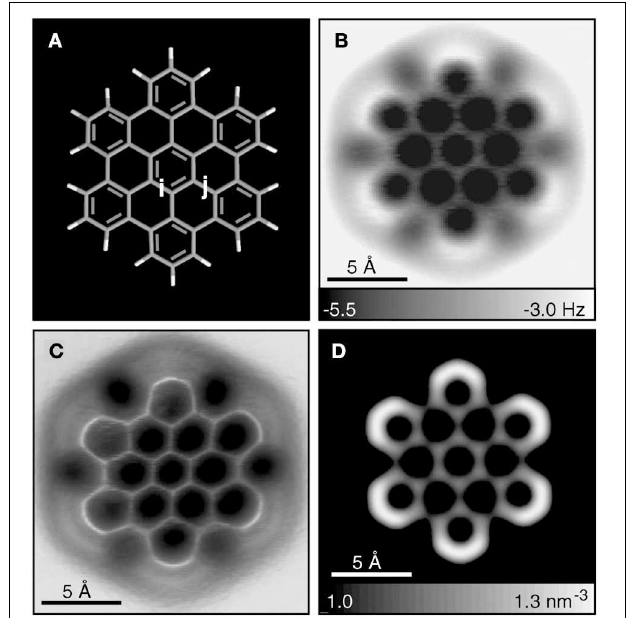
Figure 2 | Hexabenzocoronene model (A) and constant-height AFM measurements at z = 3 . 7Å (B) and 3.5Å (C). (D) Calculated electron density at a distance of 2.5Å. (Gross et al., 2012) Reprinted with permission from